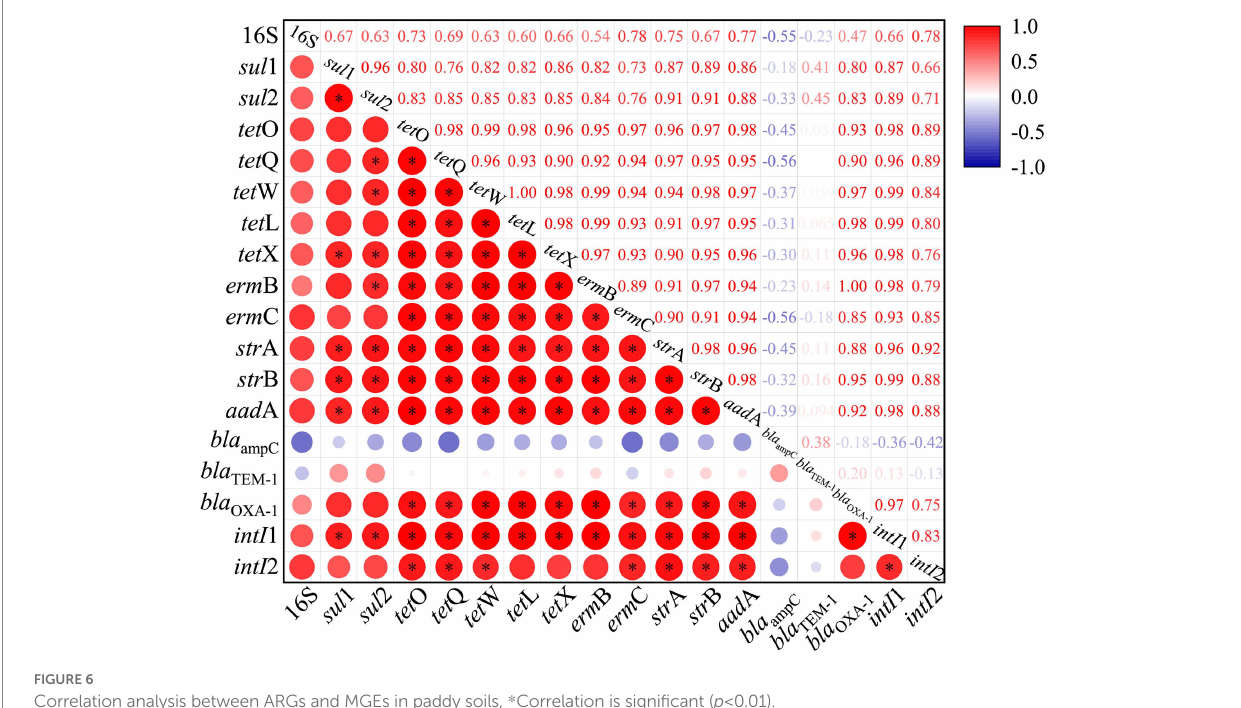
FIGURE 6 Correlation analysis between ARGs and MGEs in paddy soils, * Correlation is significant ( p < 0.01).